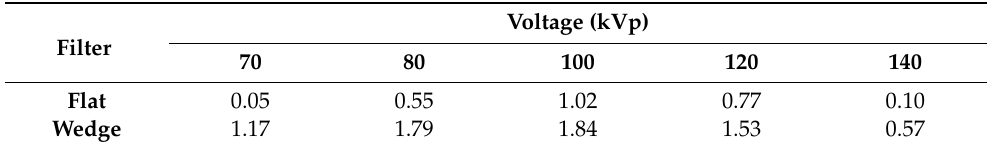
Table 3. Deviations ∆ D in percent (%) between IVISCAN ® and the ionization chamber for two filter types, Flat and Wedge, and different tube